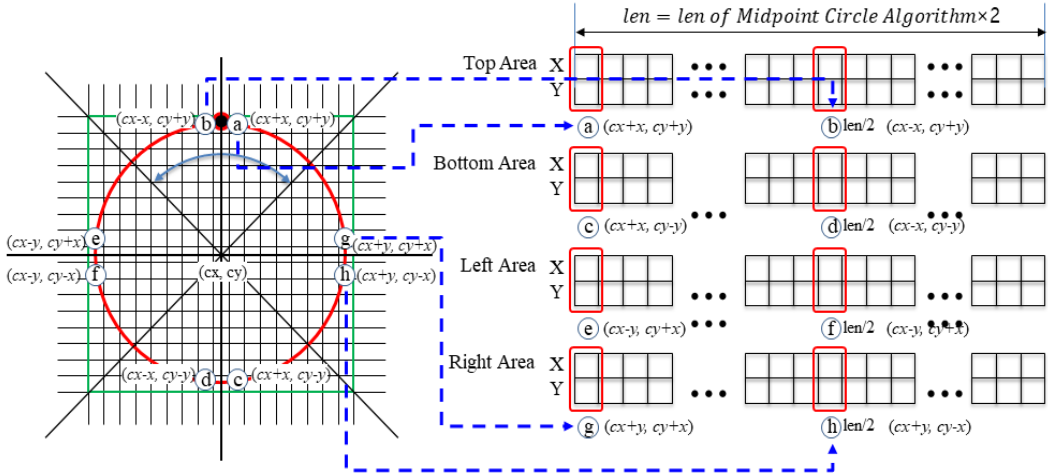
Figure 9. Generation of a circular coordinate array.